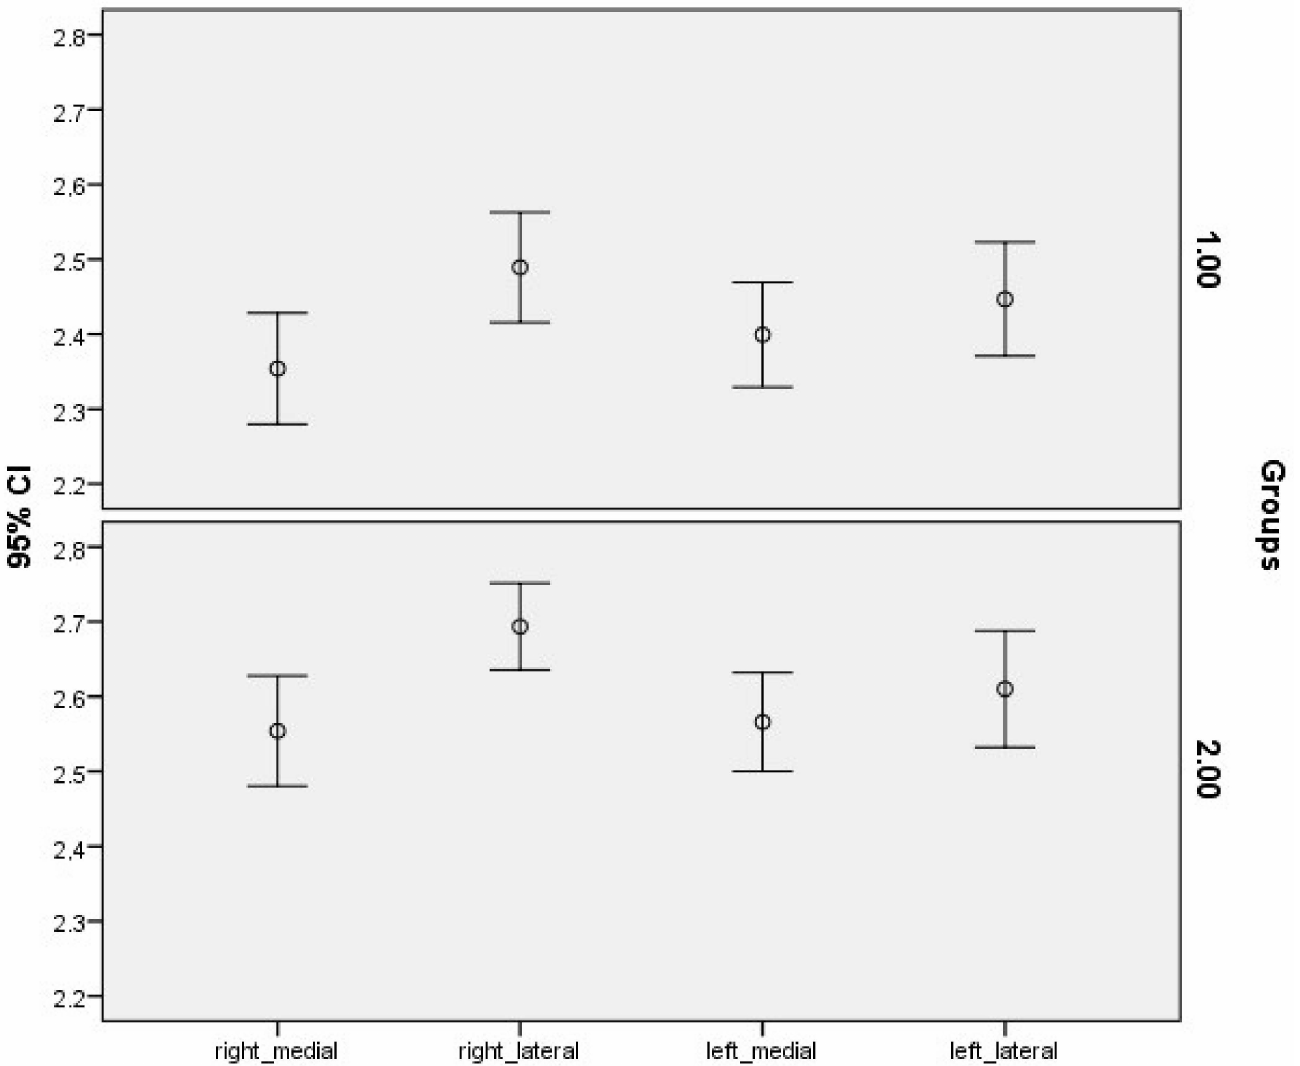
Figure 3. Error bars for cortical thickness in groups. 1: Patient group, 2: